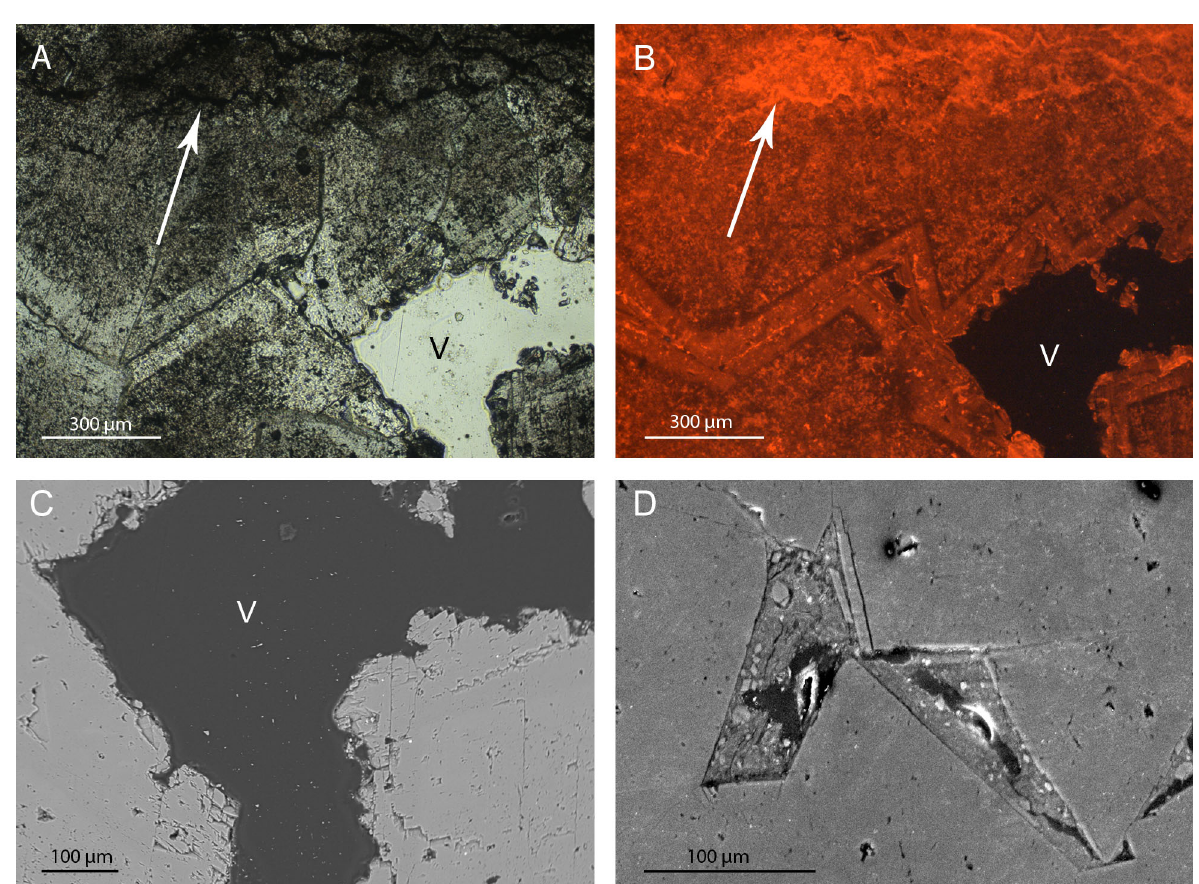
Fig. 10. Sucrosic dolomite in light microscope ( A ), cathodoluminescence (CL) ( B ) and scanning electron microscopy (SEM) in the backscattered electron imaging (BSE) mode ( C ). In light microscope and CL views a low-amplitude stylolite is observable (arrow). The vug (V) is lined with tiny crystals exhibiting in CL brightly luminescent colour similar to the stylolite plane, Ape drill core, 1.4 m, GIT 442-585. ( D ) Illite filling in the intercrystalline pore space of sucrosic dolomite, SEM in the BSE mode, Tsiistre drill core, 47.2 m. GIT 441-419.